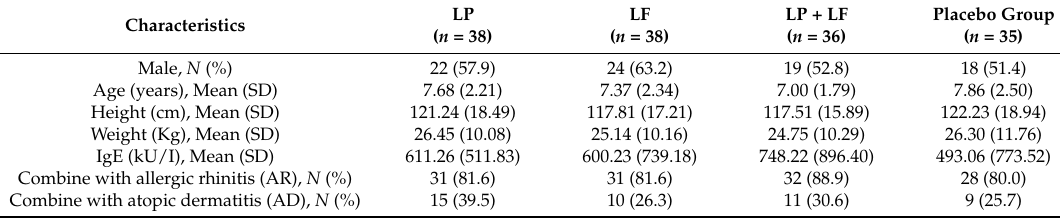
Figure 2. Study protocol. Table 1. Baseline demographic characteristics of study participants ( N = 147).